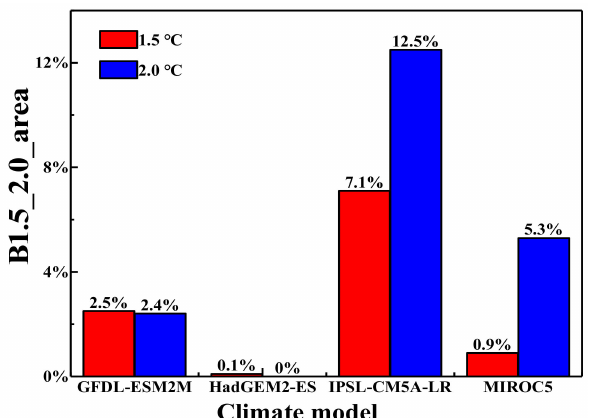
Figure 8. The percentages of areas where the temperature increase is below the global values of 1.5 and 2.0 ◦ C (B1.5_2.0_area, Units: